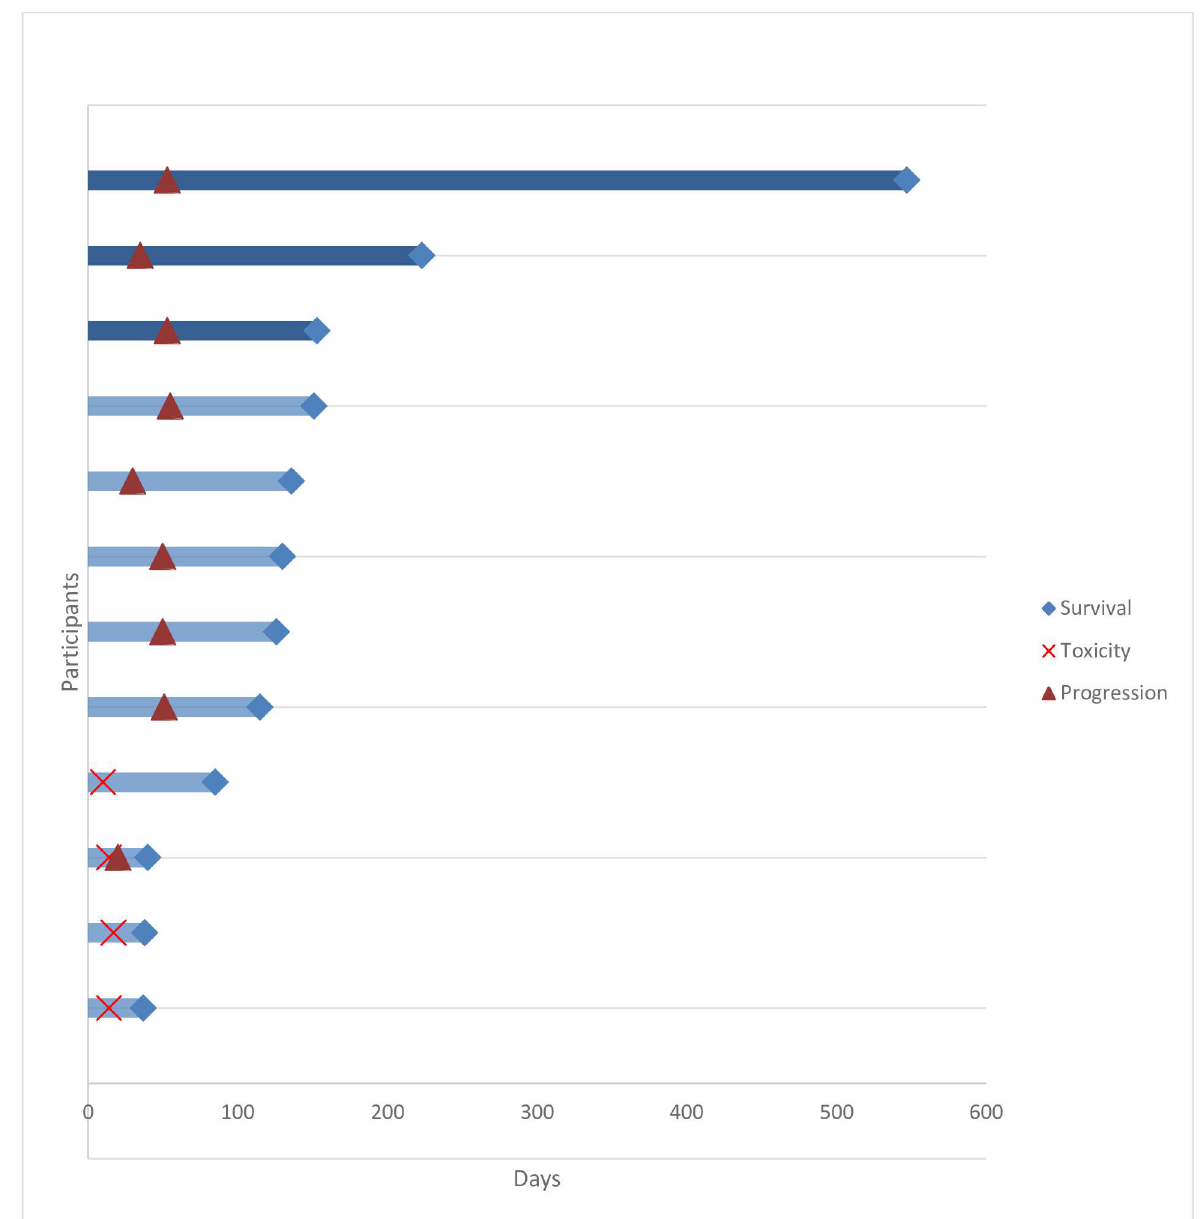
Fig 3. Swimmer’s plot. Swimmer’s plot of time to progression,time to toxicity causing early discontinuation of study drug, and time to death (overall survival). Three of three patients who progressed on CPI-613 and were subsequently started on topotecanthen demonstrated treatment response with survival for 547, 223, and 153 days (dark blue